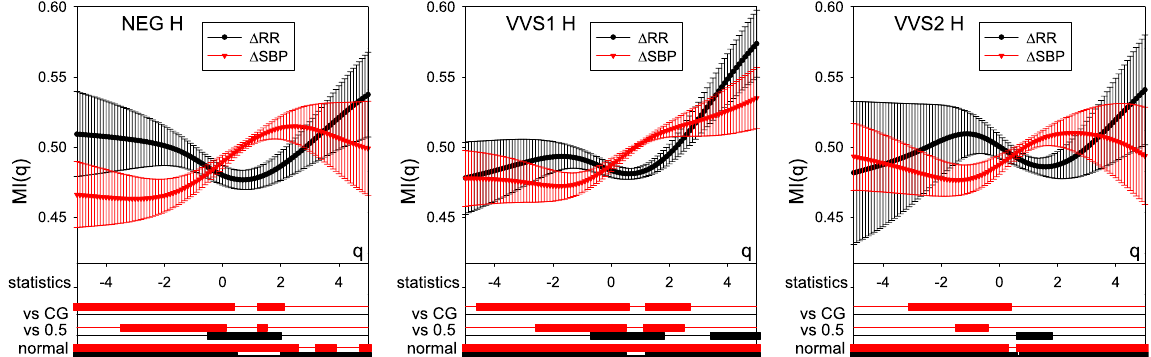
Figure 3. Plots of the mean MI q ( ) and MI q ( ) (with std errs) obtained for patient groups NEG, VVS1 and RR SBP VVS2 in the time window H. Below the q -axis, the statistics of the group results are given subsequently: bottom two lines mark q intervals in which the hypothesis of normality cannot be rejected (Lilliefors test, p < 0.05); middle two lines mark q intervals in which MI s are distinct from 0.5 (two-sided t , p < 0.05); top two lines mark q intervals in which MI s are distinct from the corresponding MI s of the CG ( t -test for independent data, p < 0.05). Black curves refer to RR data; red curves describe SBP